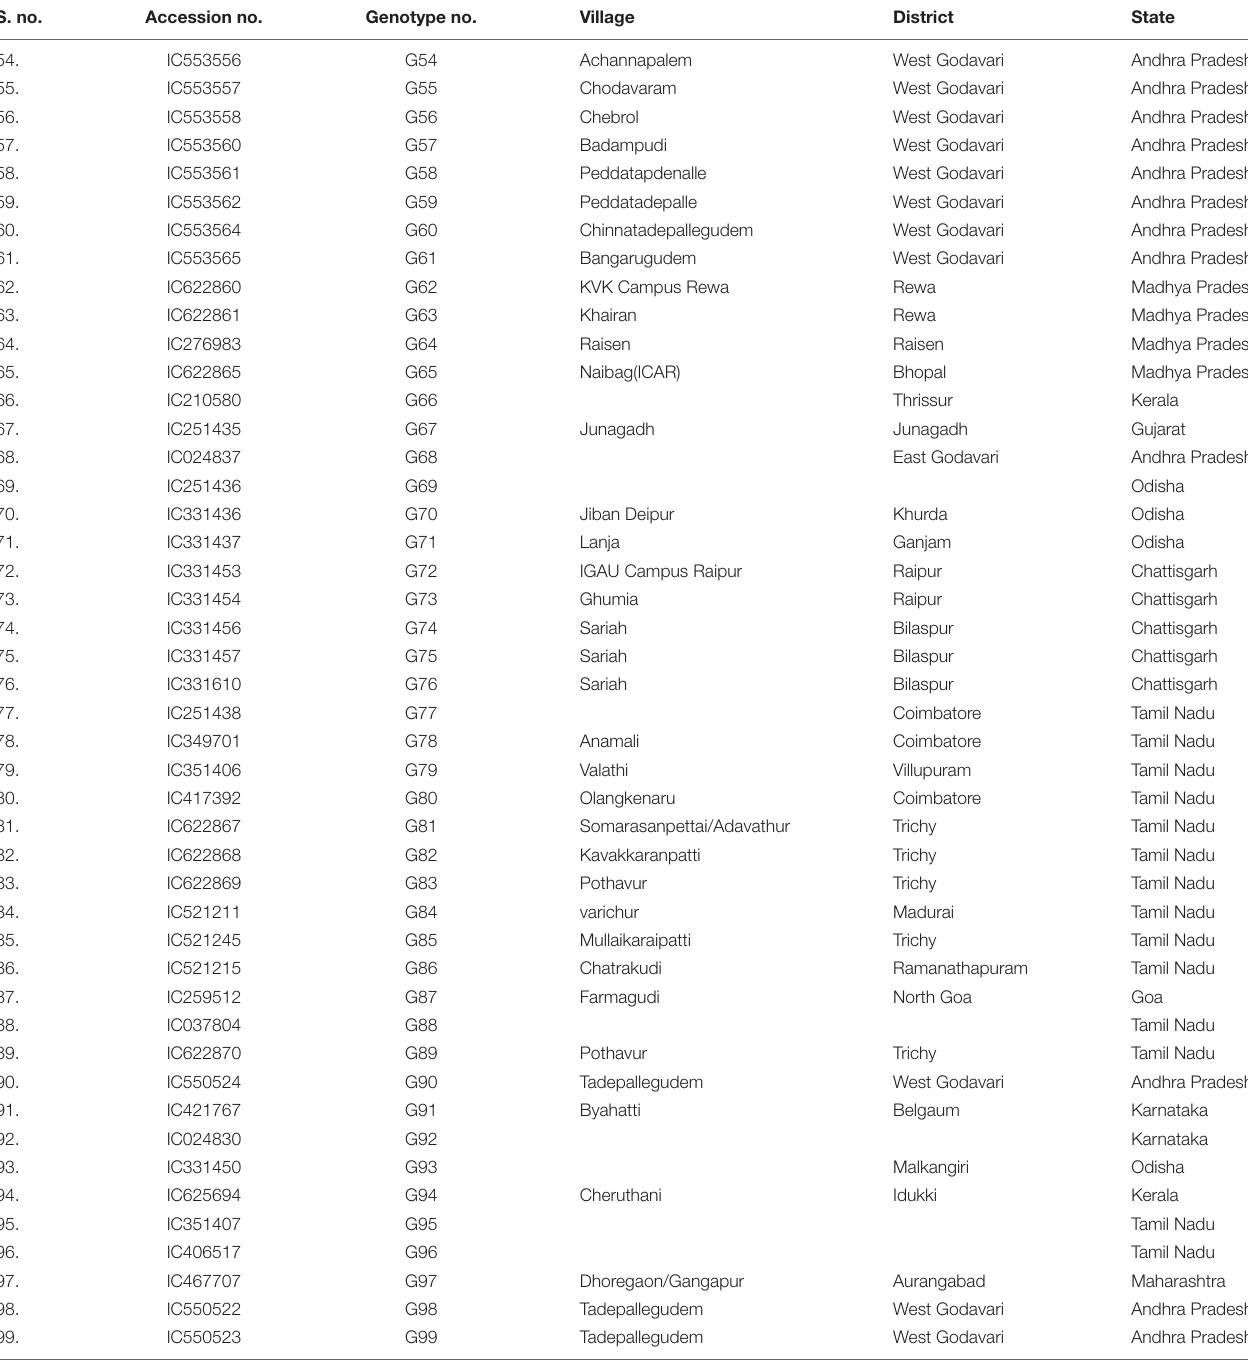
and 18 mg for male and female, respectively whereas for Zn it is 11 and 8 mg for male and female, respectively. In the case of Ca, the RDA per day per person is 1000 mg for both sexes where as, for protein, the % RDA is 56 g for an adult man and 46 g for an adult woman. This % RDA was calculated for the female/male belonging to the 9 to 50 years age